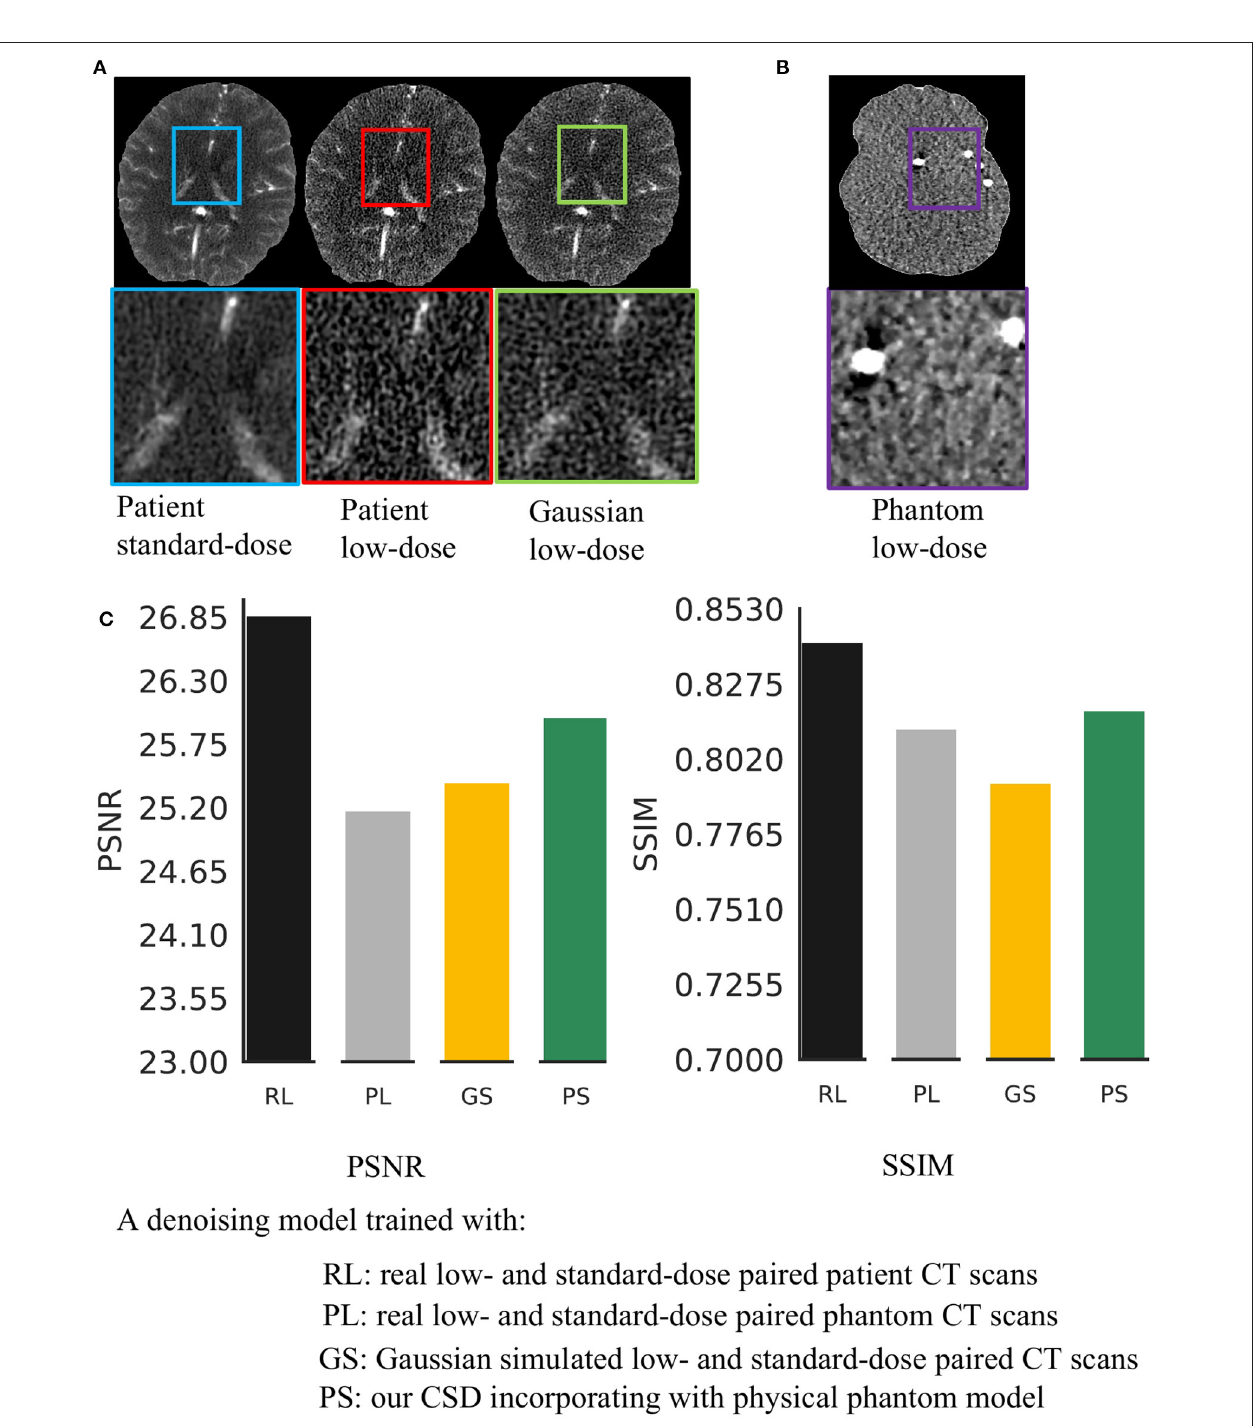
FIGURE 1 | Real low-dose has a different noise distribution from Gaussian noise and is hard to remove. (A) It shows a visual comparison of the standard-dose computed tomography (CT), real low-dose CT, and Gaussian simulated low-dose CT scans. (B) It shows a low-dose CT scanned by using a physical phantom model. (C) We trained four same structural Deep Neural Network (DNNs) using various types of low-dose noise with the same noise level (20 mAs radiation dose) and then compared the effectiveness of noise removal.